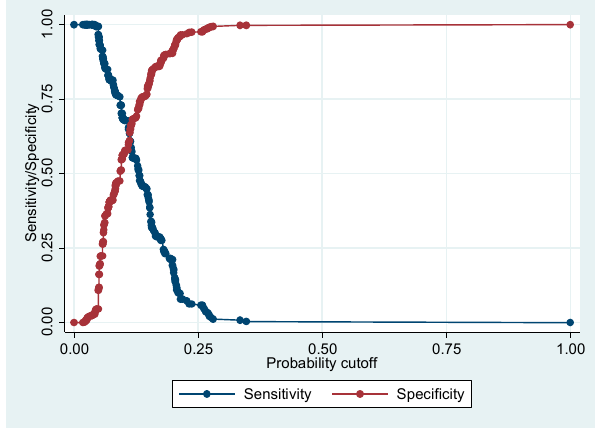
Figure 1. Graph area under ROC curve. Number of observations = 3354. Area under ROC curve = 0.6662.